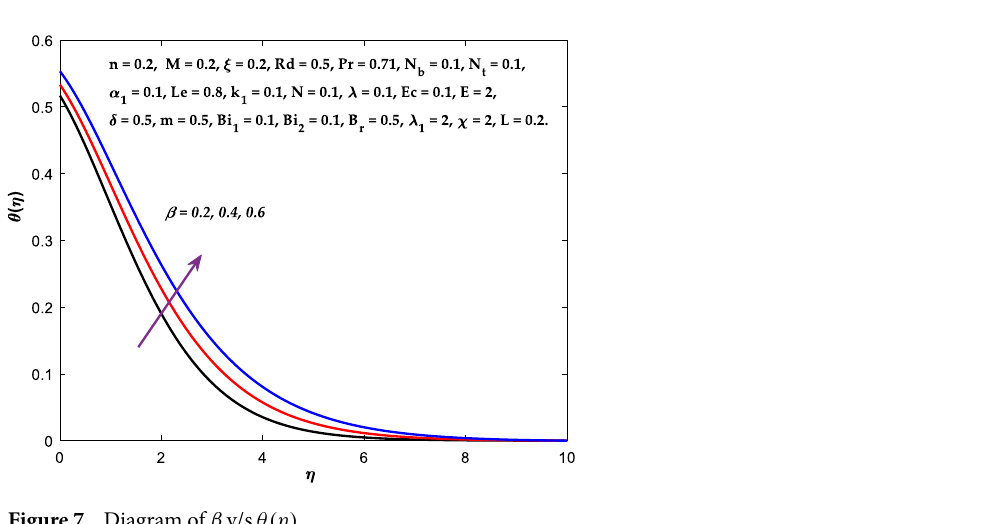
Figure 7. Diagram of β v/s θ(η)